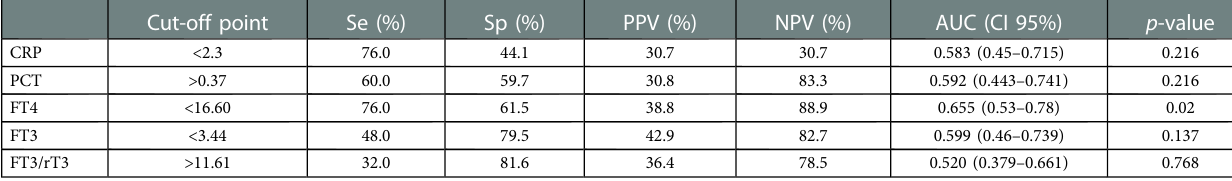
TABLE 3 Optimal cut-off points and accuracy indicators for in fl ammatory biomarkers and hormones to differentiate higher and lower score risk mortality groups. Cut-off